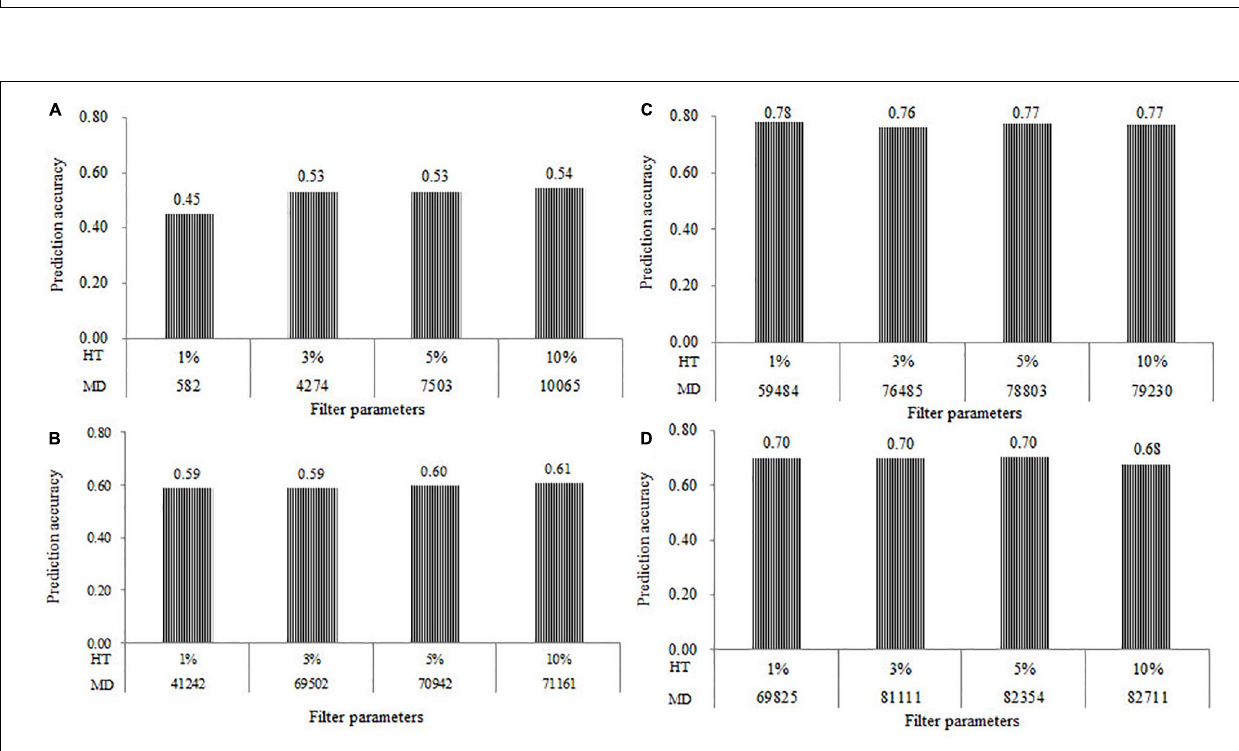
FIGURE 3 | Genomic prediction accuracies for TSC resistance obtained in the (A) DTMA association mapping panel, (B) Pop1; (C) Pop2; (D) Pop3, under the different levels of marker density (MD) at the four levels of heterozygosity rate (HT) of SNPs at 1, 3, 5, and 10%, and filtered with the combination of minor allele frequency (MAF) of 0.05 and missing rate (MR) of